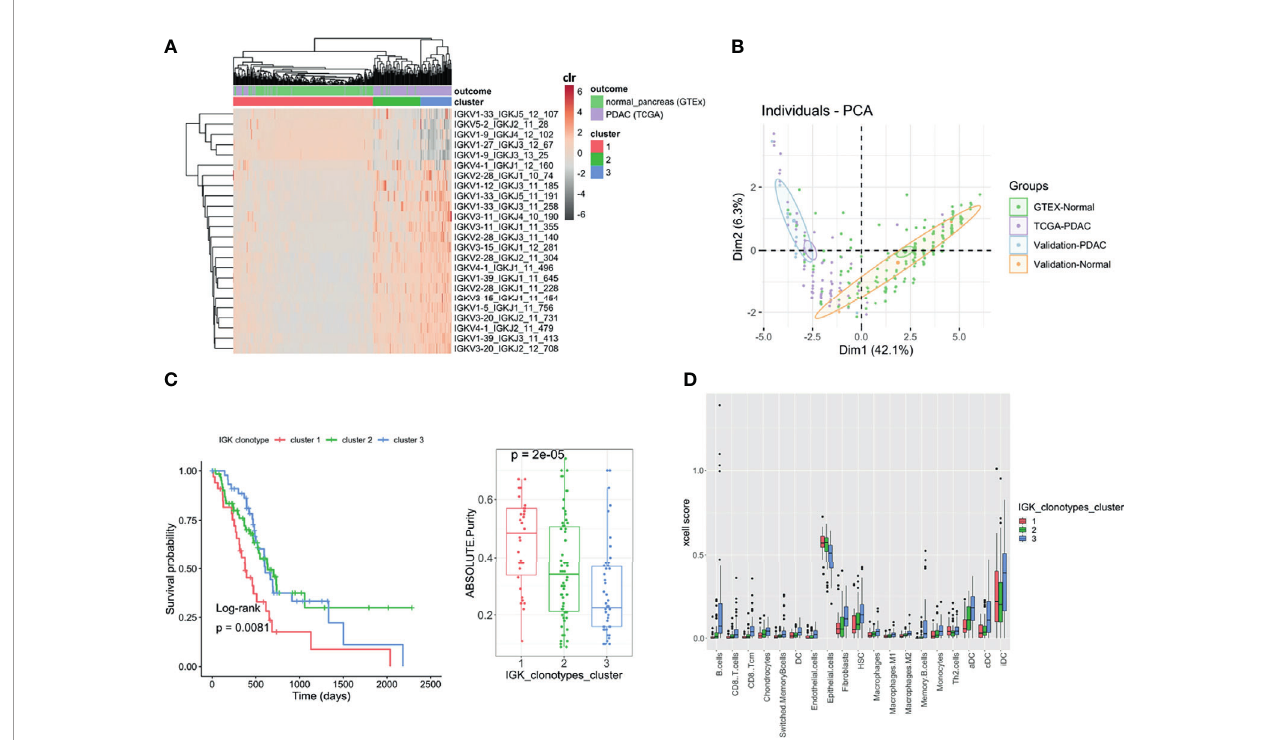
FIGURE 6 | Clonotype analysis. Heatmap showing the IGK clonotypes selected by CLR-LASSO to discriminate PDAC (TCGA) vs . Normal Pancreas (GTEx). The three main clusters are obtained by unsupervised cluster analysis using hierarchical clustering (A) . Bi-plot showing the two fi rst principal component analysis using the 24 clonotypes selected and applied to both discovery and validation datasets (B) . Kaplan – Meier curves for overall survival with the three clusters obtained and the boxplot with the tumor purity measured using ABSOLUTE 7,27 that infers the purity based on DNA somatic mutations (C) . Comparison between the three clusters with the cell content deconvoluted using xCell. Those cells are the ones that show signi fi cant differences across the three clusters using Kruskal – Wallis test (FDR < 0.05) (D)